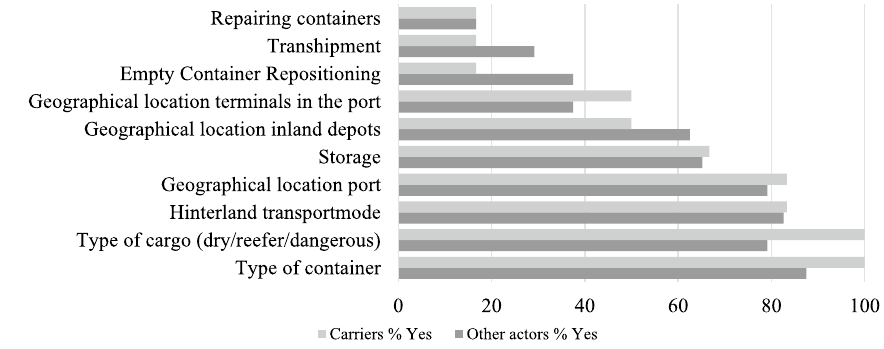
Fig. 4 Cost elements (in %). Source : own